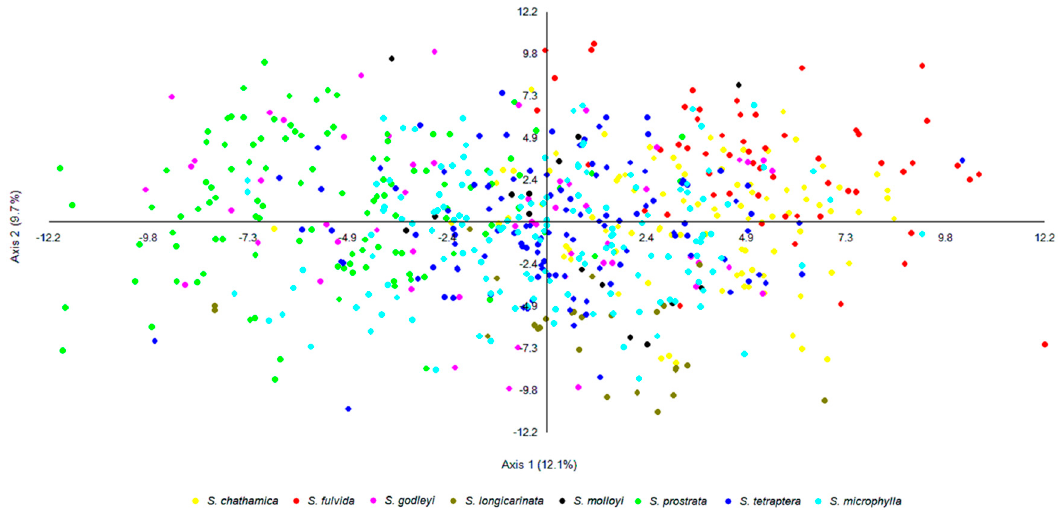
Figure 4. Genetic clustering based on a Principal Coordinates Analysis using the software MVSP [22]. The first two axes explain 12.1% and 9.7% of the total variance. The symbol colours correspond to the morphological groups (see Figure 2).